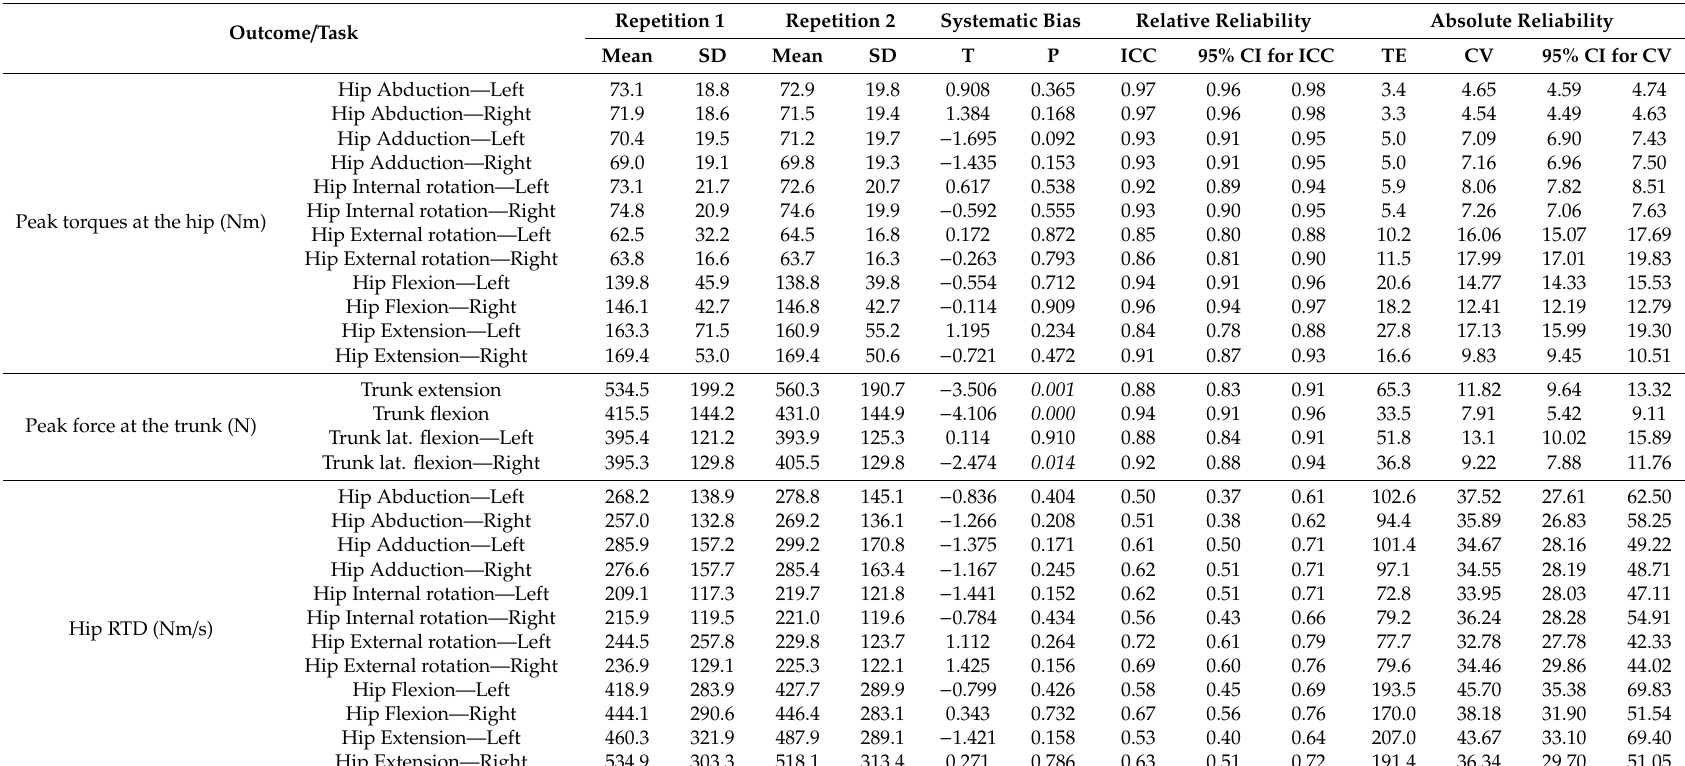
Table 1. Reliability results for outcome